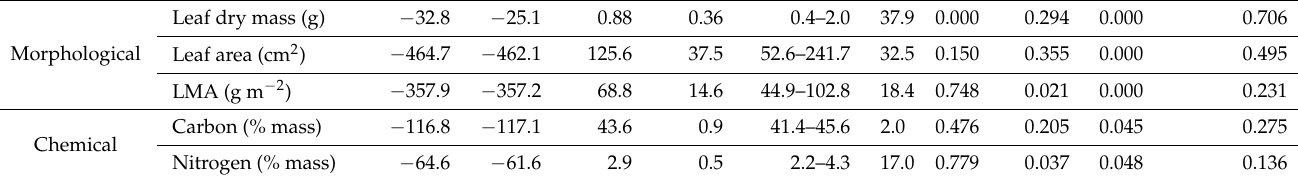
Trait distributions were determined based on the highest log-likelihood. For nor- mally distributed traits, means and standard deviations (SDs) are presented, whereas for